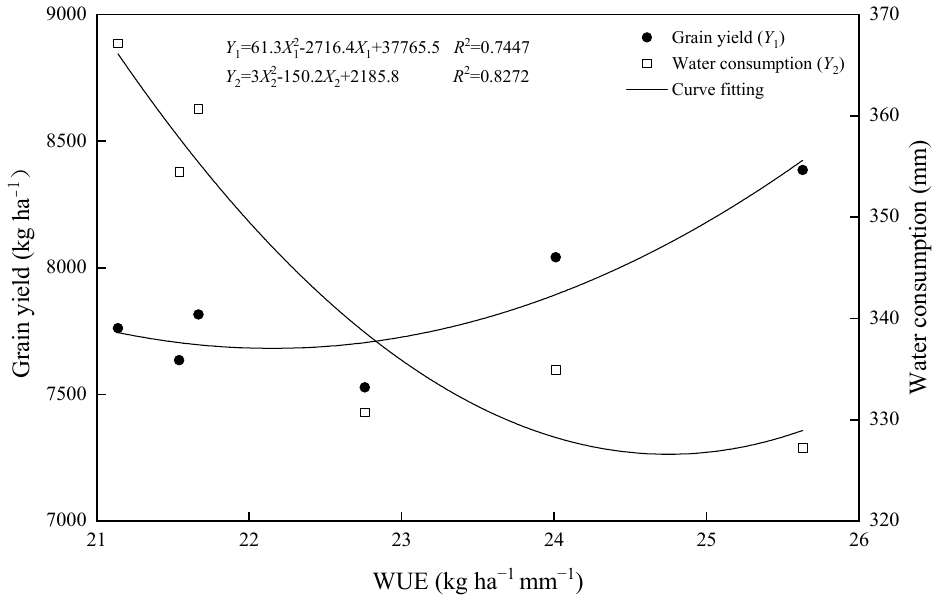
Figure 6. Relationship between grain yield and water use efficiency, and between water consump- tion and water use efficiency for winter wheat. and water use efficiency for winter